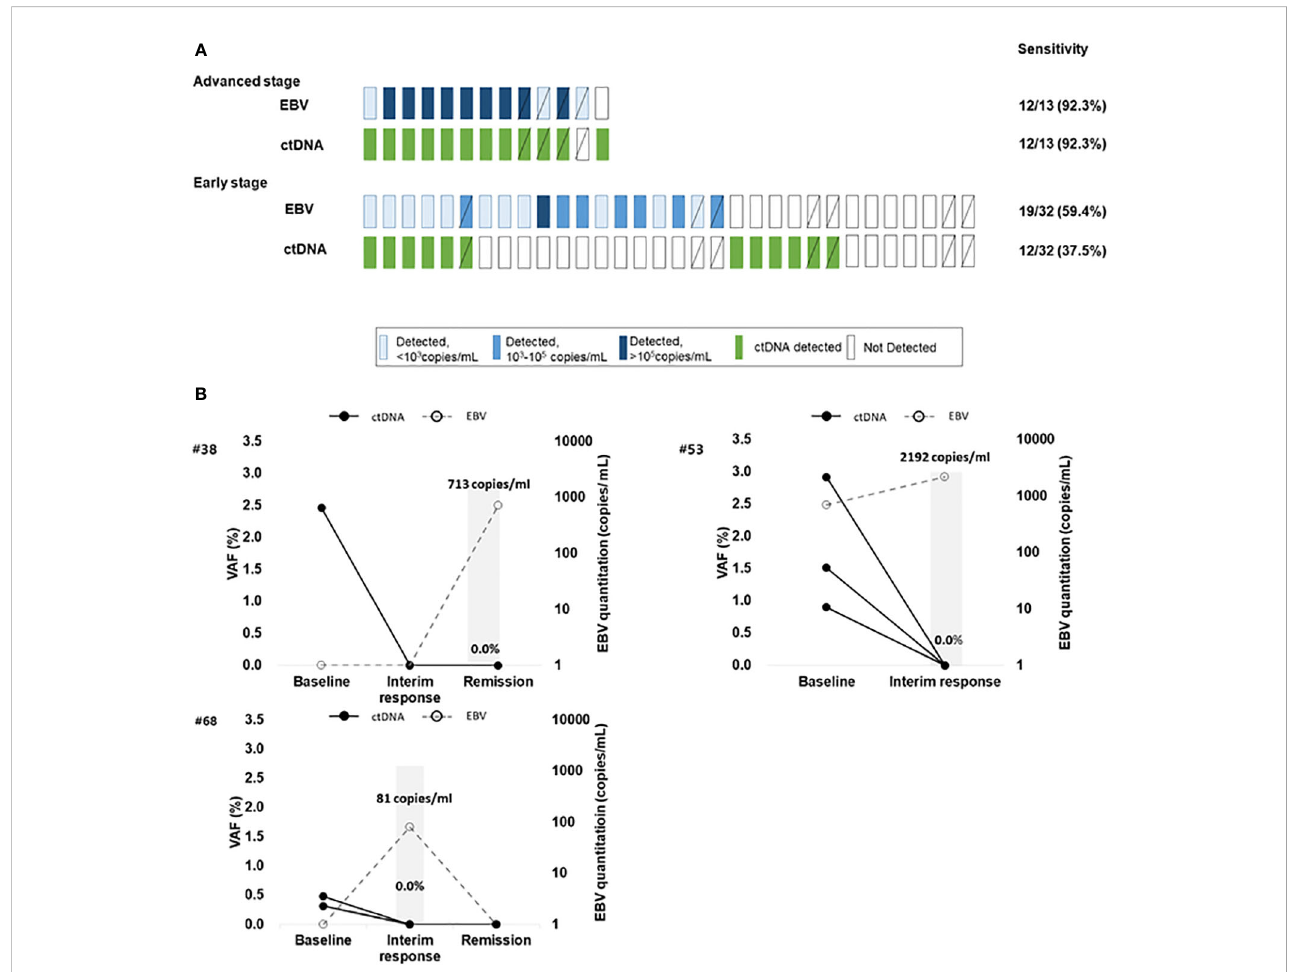
FIGURE 3 (A) The detection of ctDNA mutations and EBV DNA quantitation in ENKTL patients at baseline. The difference in detection of ctDNA mutation and EBV DNA according to disease stage. Diagonal lined boxes indicate patients with baseline sampling at the time of relapse (B) Three ENKTL patients with discrepant results between trackable ctDNA mutations and EBV DNA quantitation results who achieved complete disease remission Patient #53 had elevated plasma EBV DNA after concurrent chemo radiotherapy (CCRT). The patient showed a complete response to the therapy but died of sepsis; EBV DNA elevation in this patient could be attributed to causes other than ENKTL progression. Two patients (Patient #68 and patient #38) showed transient elevation of EBV during chemotherapy and there was no sign of residual disease judged by CT or patients ’ clinical status, and the patients maintained remission without relapse. The bold black line indicates the mutation frequency changes in patients, and the dotted line indicates the EBV DNA quantitation